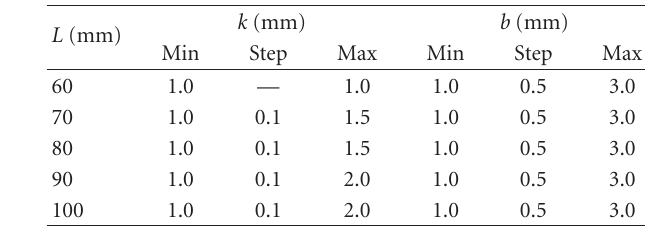
Table 2: Di ff erent widths of conductor and thicknesses of PCB for antennas with di ff erent side